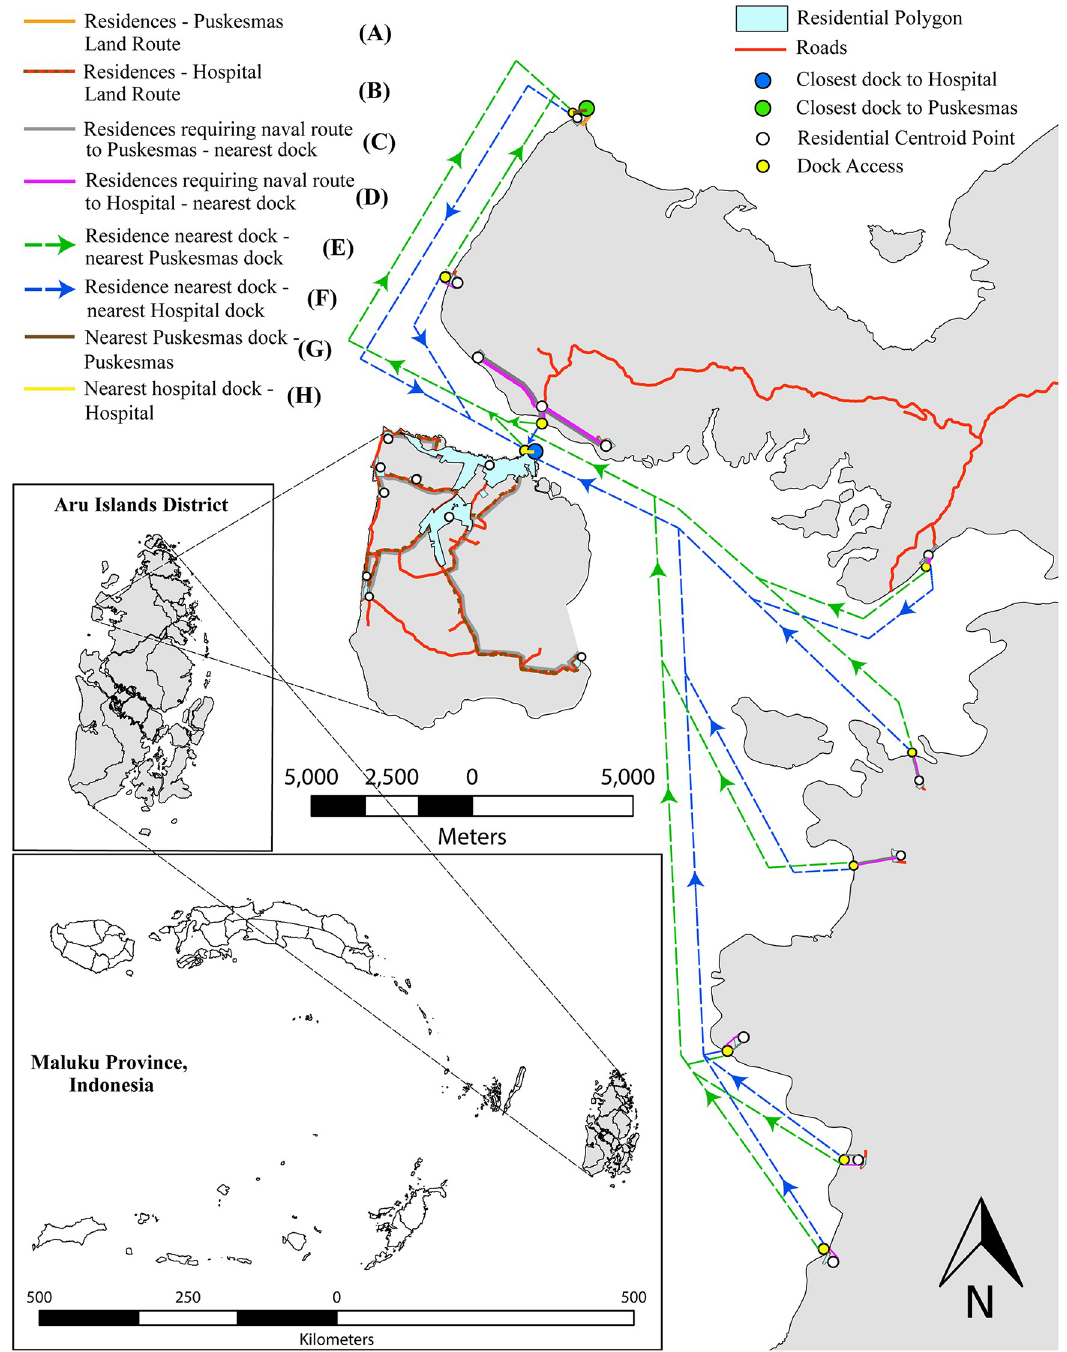
Fig 2. Example of route types and their corresponding values (in reference to Table 2). Base map provided by GADM https:// gadm.org/maps/IDN.html. License https://gadm.org/license.html.